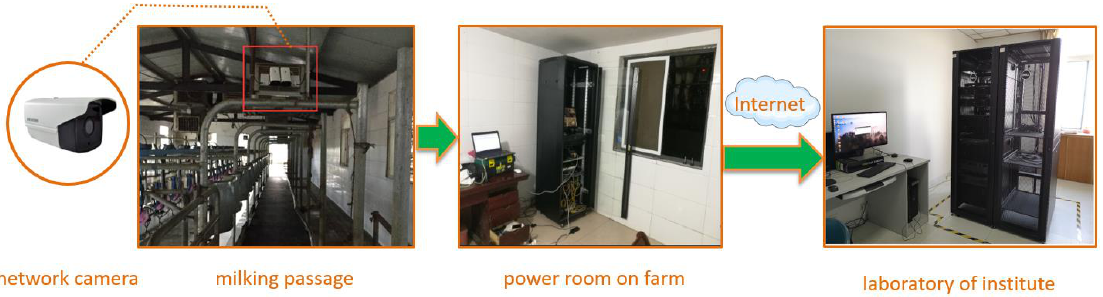
Figure 2. Network camera and equipment for remote monitoring platform.